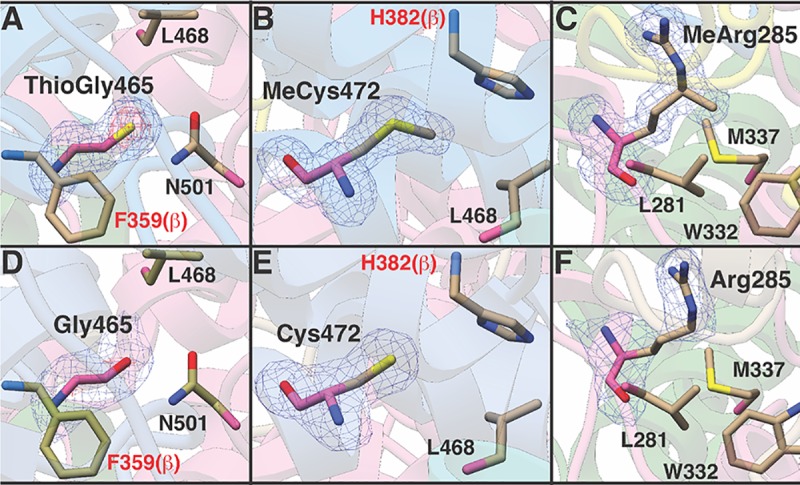
Absence of modified amino acids does not change the structure of MCR.(A–C) The local structure near Gly465 (modified to ThioGly), Cys472 (modified to MeCys), and Arg285 (modified to MeArg) in wild type. (D–F) The local structure near the unmodified Gly465 residue, unmodified Cys472 residue, and unmodified Arg285 residue in MCR derived from the ΔycaO-tfuA, ΔmcmA, ΔmamA single mutants, respectively. The structure of MCR purified from the double and triple mutants was indistinguishable from that shown here, with RMSD between all pairs ranging between 0.1–0.3 Å. mamA, methylarginine modification; mcmA, methylcysteine modification; MCR, methyl-coenzyme M reductase; MeArg, 5-(S)-methylarginine; MeCys, S-methylcysteine; RMSD, root mean square deviation; ThioGly, thioglycine.